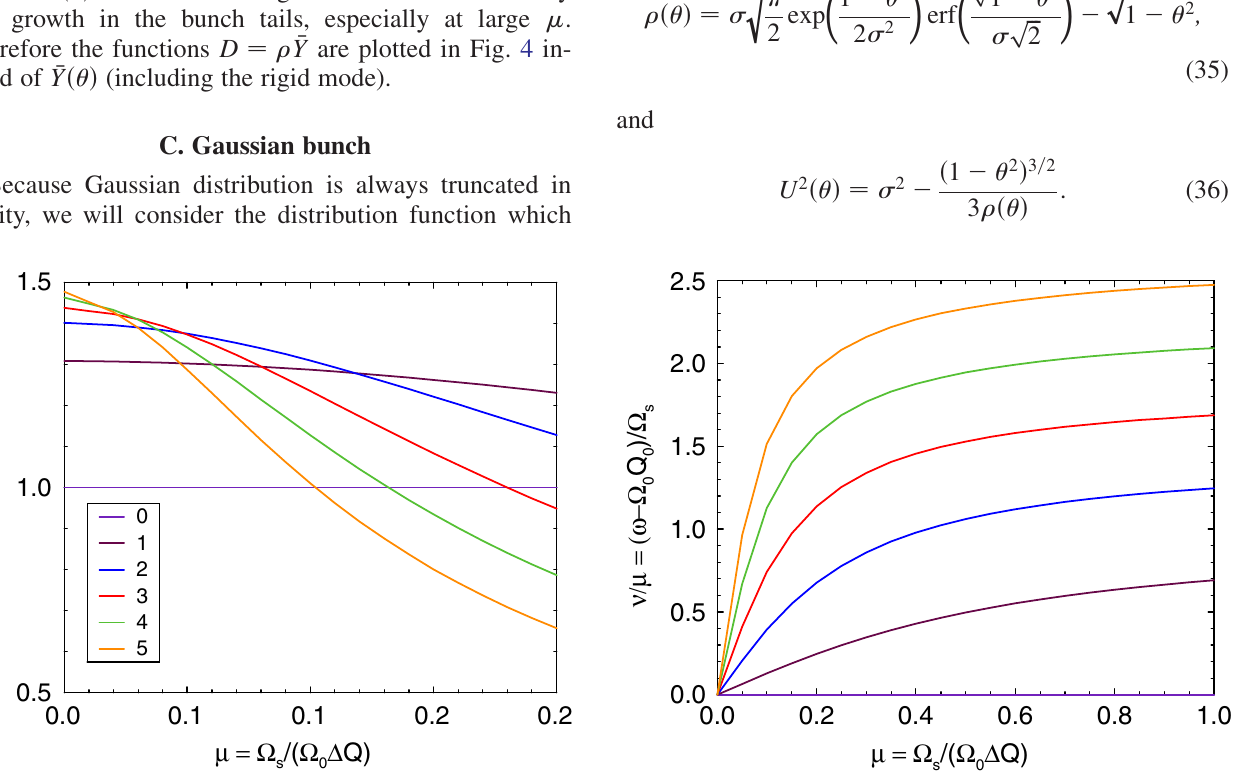
FIG. 7. (Color) Eigenvalues of the Gaussian bunch at (cid:10) ¼ 1 = 3 , low (cid:7) .